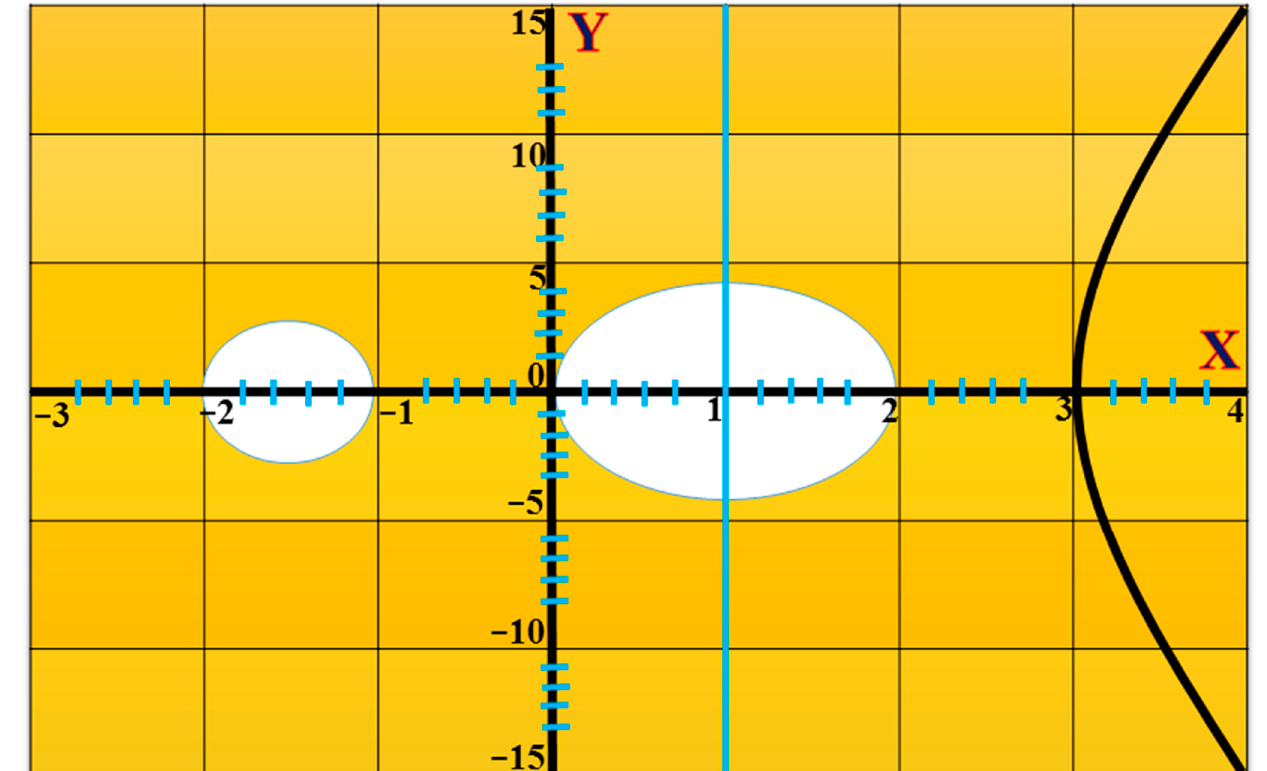
Figure 1. Hyperelliptic curve (genus = 2).